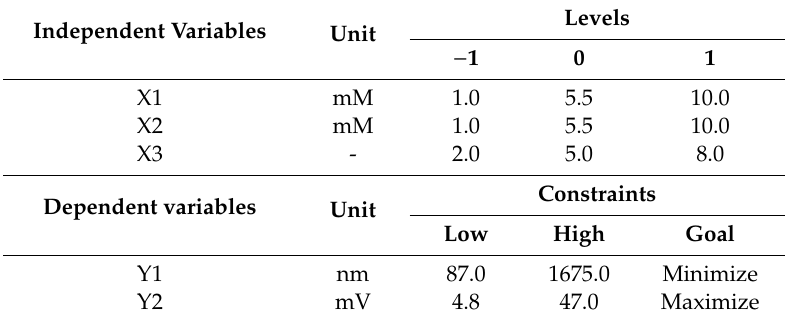
Table 4. Independent (X1–X3) and dependent (Y1 and Y2) variables of FLV–TAT formulations utilized in the factorial design. Independent